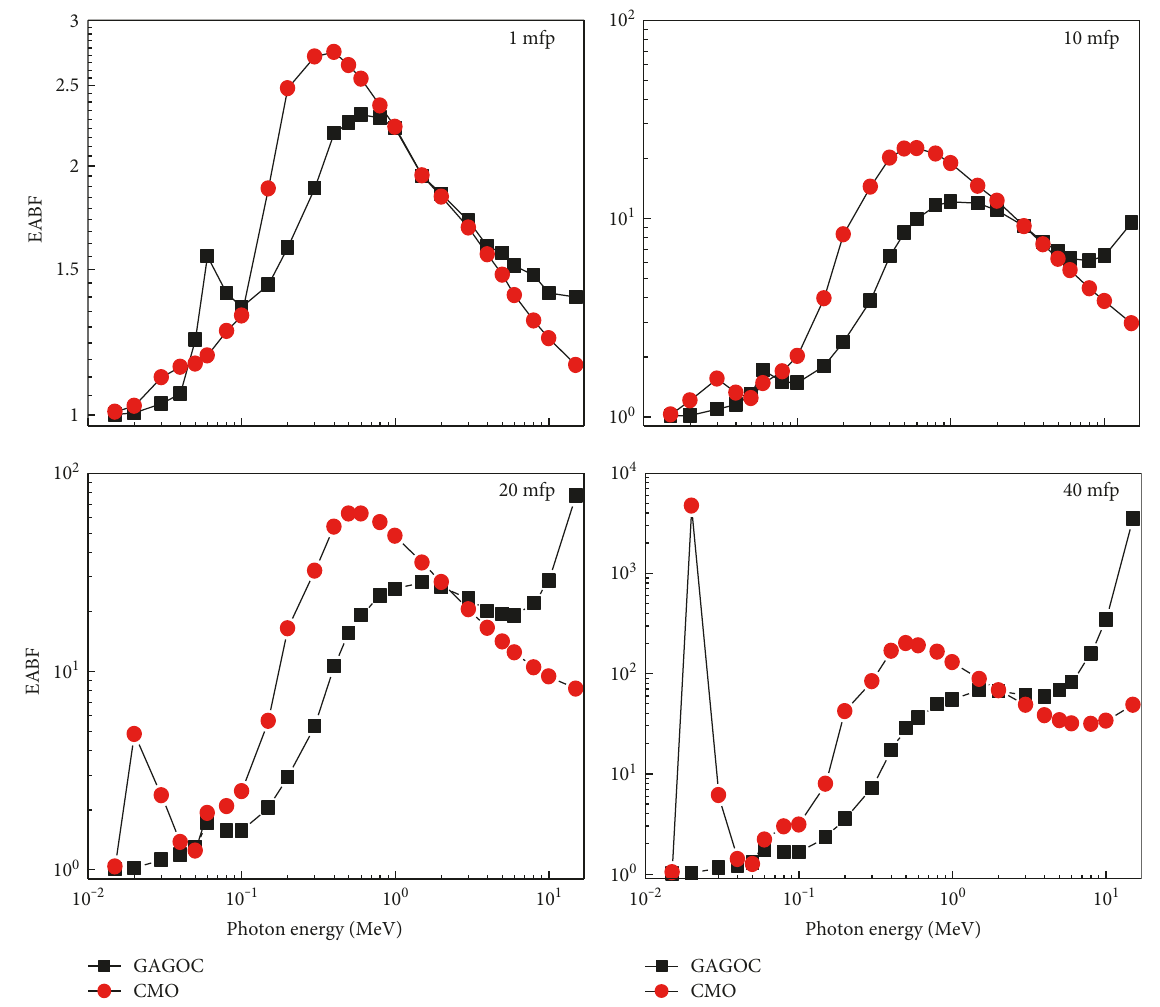
Figure 9: EABF variation for GAGOC and CMO with incident photon energy ant 1, 10, 20, and 40